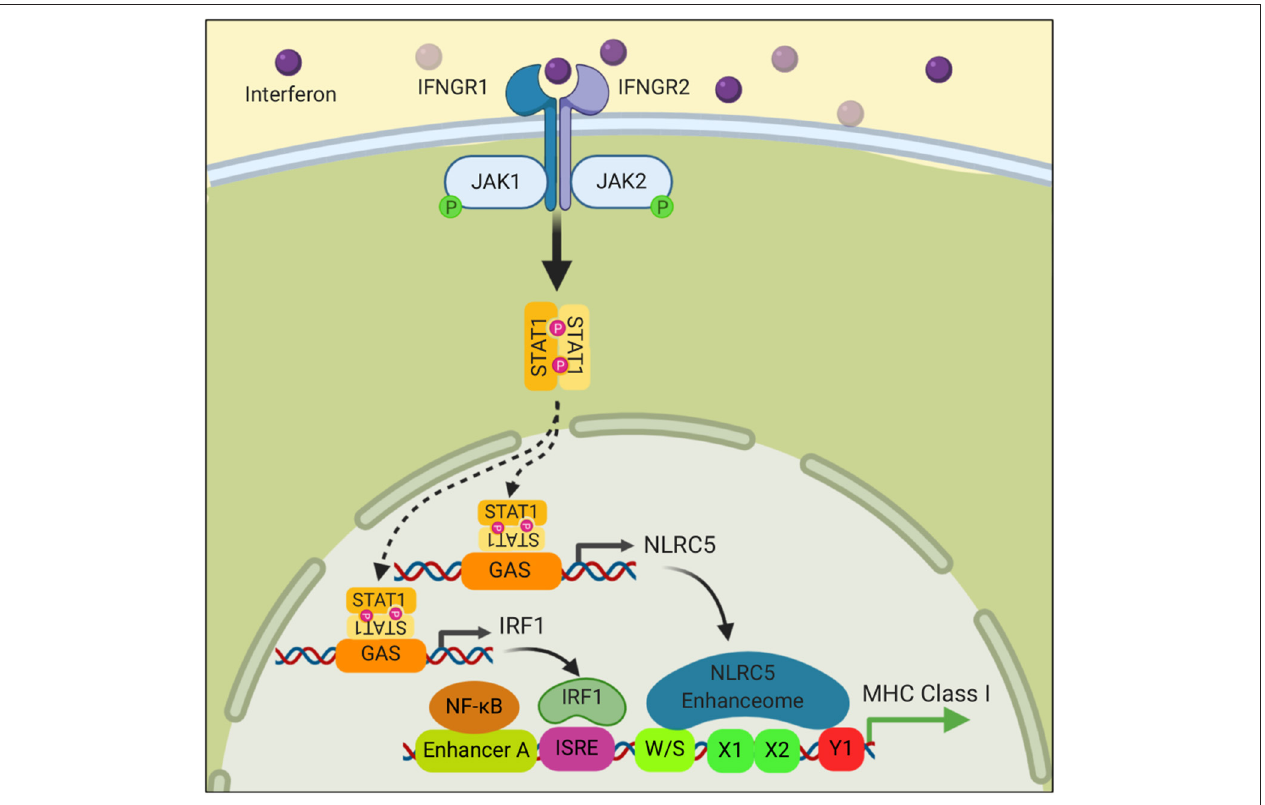
FIGURE 3 | Interferon signaling stimulates the transcription of MHC class I genes. Binding of Interferon to its receptor stimulates phosphorylation of the Janus kinases, JAK1 and JAK2, which in turn phosphorylate STAT1. Phosphorylated STAT1 translocates into the nucleus where it binds to promoter elements of NLRC5 and IRF1 and drives their transcription. NLRC5 and IRF1 then stimulate MHC I gene transcription as described in Figure 2